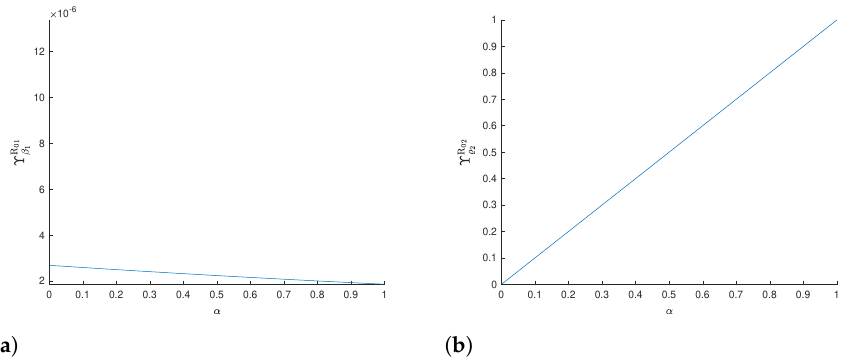
Figure 2. ( a ) Evolution of the sensitivity index of parameter β 1 , evaluated for α , with respect to R 0 1 (first community); ( b ) Evolution of the sensitivity index of parameter (cid:36) 2 , evaluated for α , with respect to R 0 2 (second